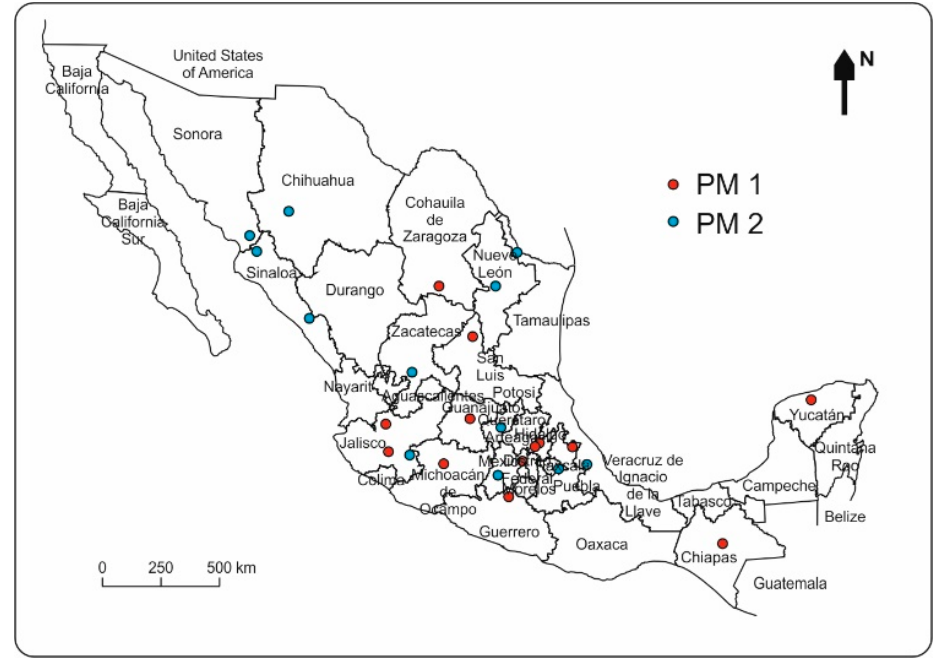
Figure 3. Location of the studied PMs in Mexico. Source: Authors’ own work. Table 2. Description of tourist values in studied PMs.